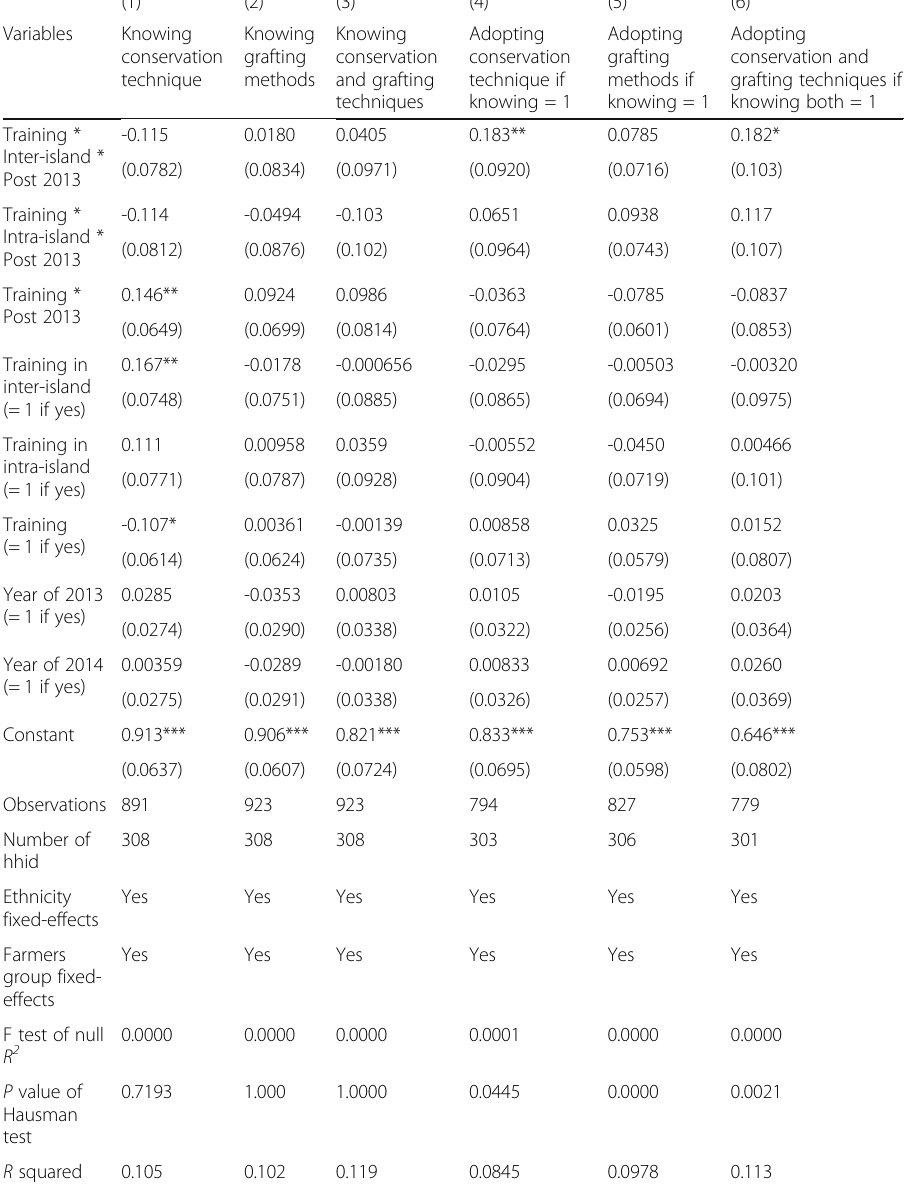
Table 5 Effects of locational heterogeneity in the training on technology diffusion and